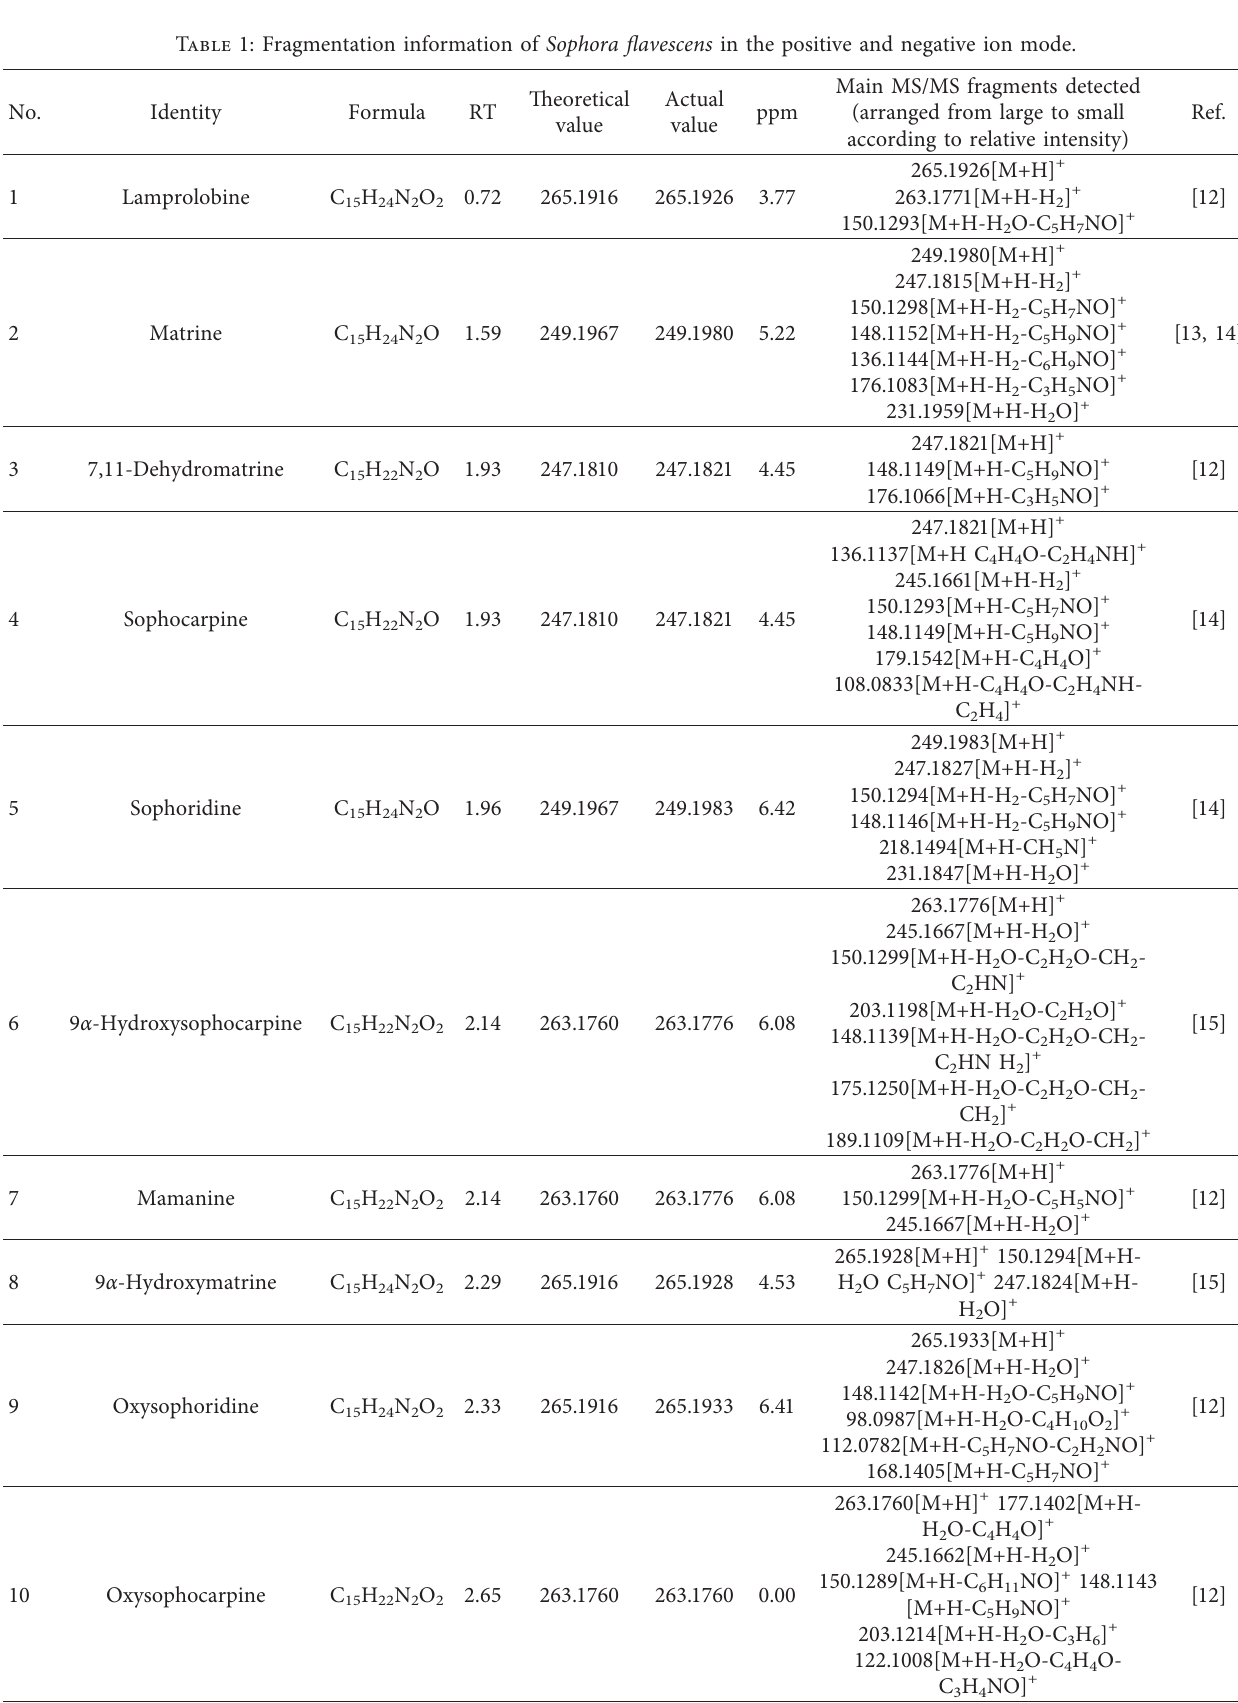
Table 1: Fragmentation information of Sophora flavescens in the positive and negative ion